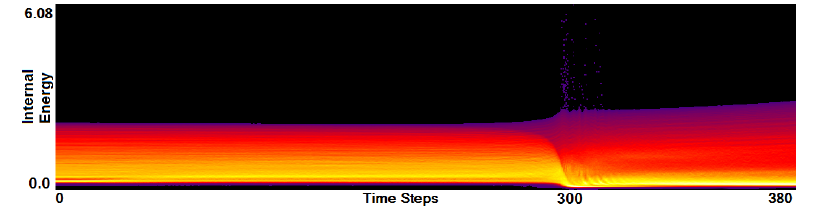
Figure 6. Function plot of the simulation of two stars both with masses equal to 1.05 of the solar mass. Time steps around 300 contain outliers in field values and exhibit a significant change in the simulation structure, while before and after this change almost steady patterns can be observed.